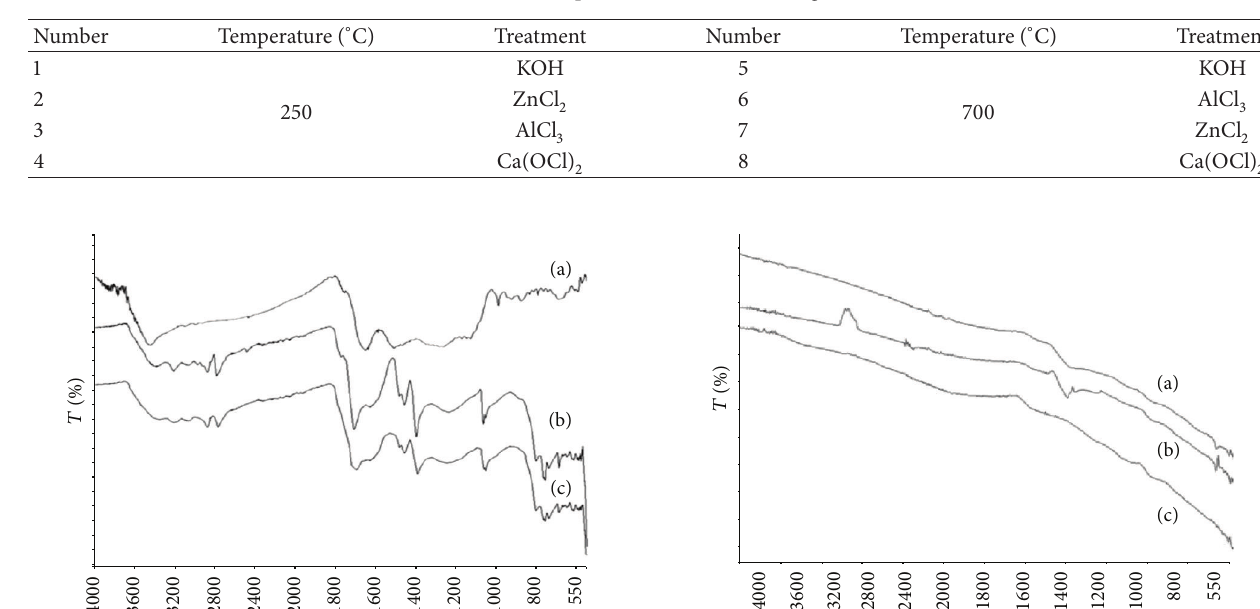
Table 2: Description of the numbers in Figure 1.